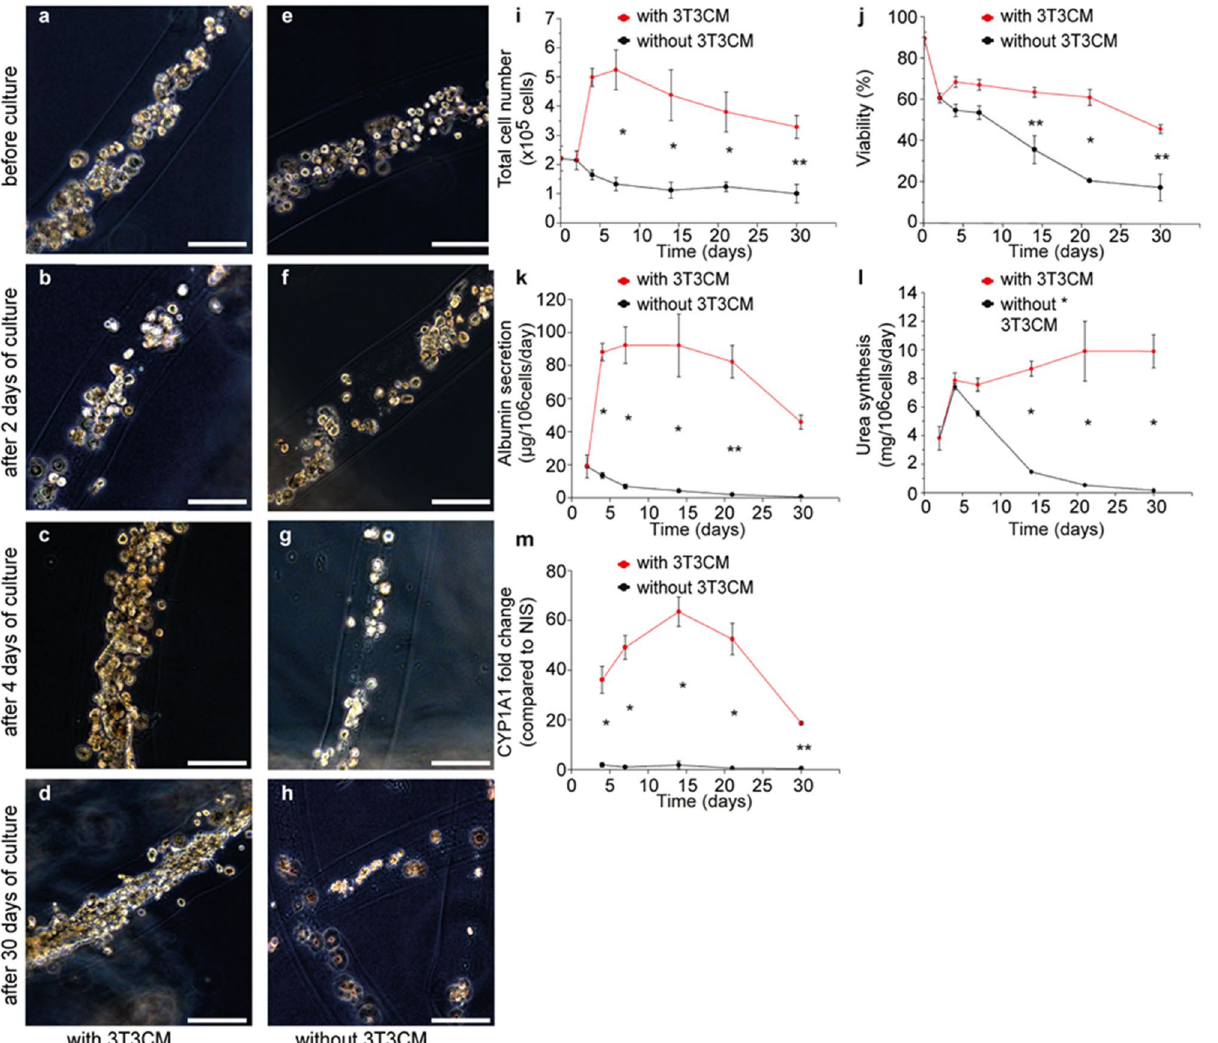
Figure 2. Culture of primary rat hepatocytes in cell fibers for up to 30 days either with or without using 3T3CM. ( a – h ) Representative dark-field images of primary rat hepatocytes encapsulated in cell fibers (n = 12 for each group) at the initial cell seeding density of 2.5 × 10 7 cells mL −1 before culture, after 2 days, after 4 days, and 30 days of culture in two experimental groups: ( a – d ) in one group 3T3CM was used after 2 days of culture, ( e – h ) while in the other group 3T3CM was not used. Scale bars; 100 µm. ( i – m ) Time course of the